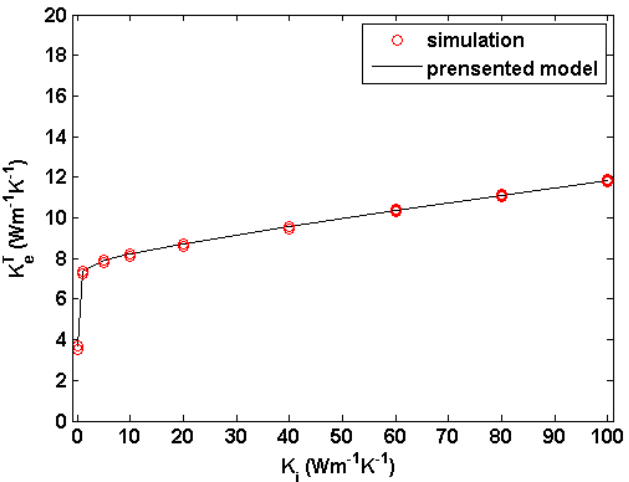
Figure 5. Comparison of the calculated transverse thermal conductivity of three-phase system and the predicted values by the presented model for K T = 3 W · m − 1 · K − 1 , K m = 20 W · m − 1 · K − 1 , V f = 0.5 and V i = 0.05. The three-phase system is composed of fiber, interface layer and matrix.